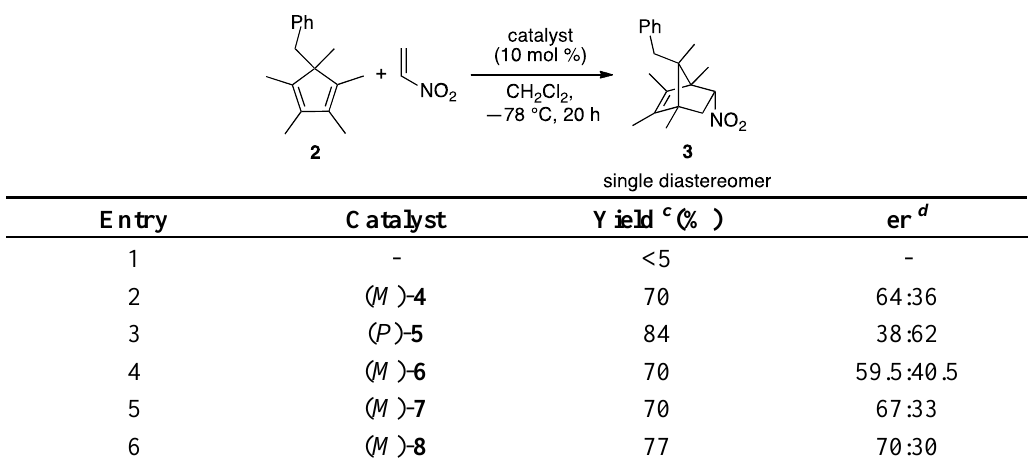
Table 1. Evaluation of catalysts for nitroalkene Diels-Alder reaction a,b